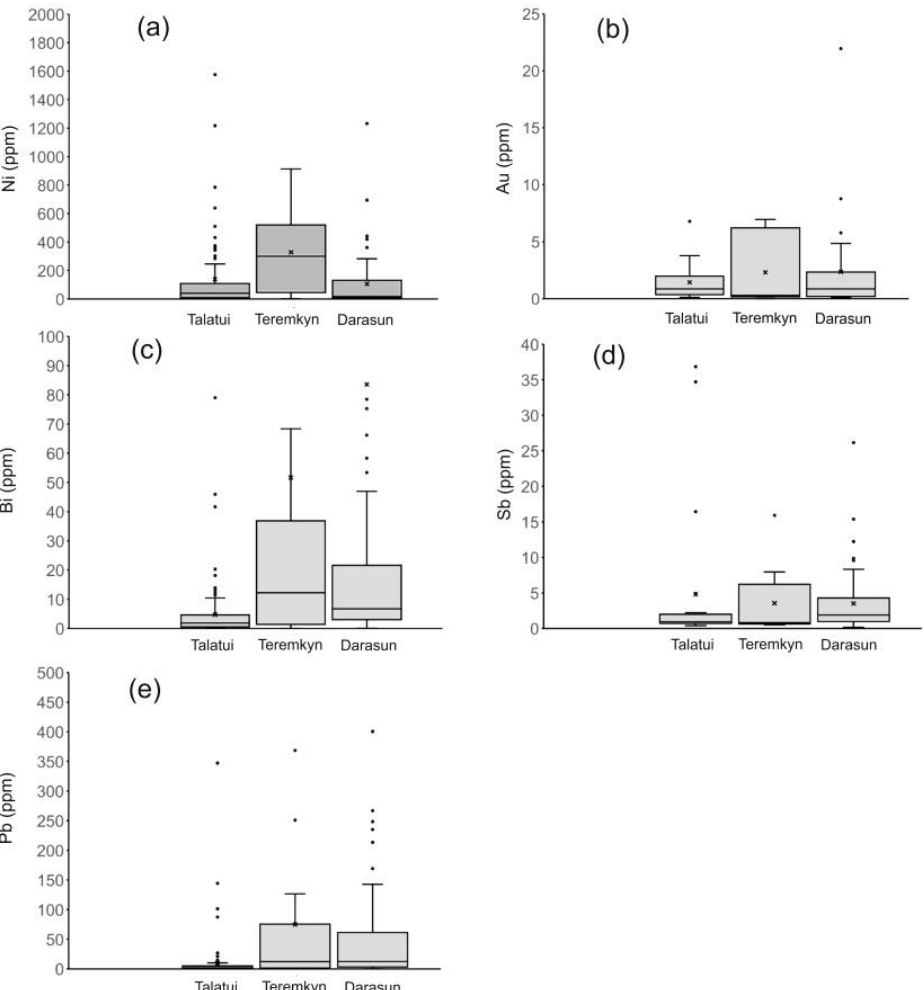
Figure 12. Boxplot diagrams of elements whose concentrations show no relation to the temperature changes: a —Ni, b —Au, c —Bi, d —Sb, e —Pb.